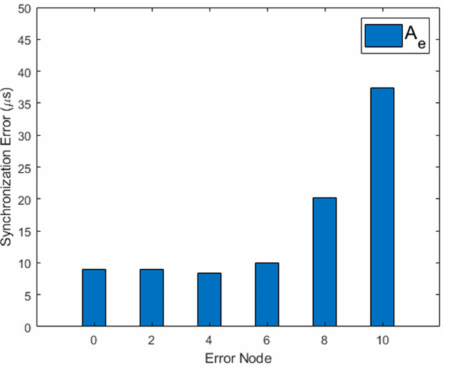
Figure 17. Network error with increasing malfunction